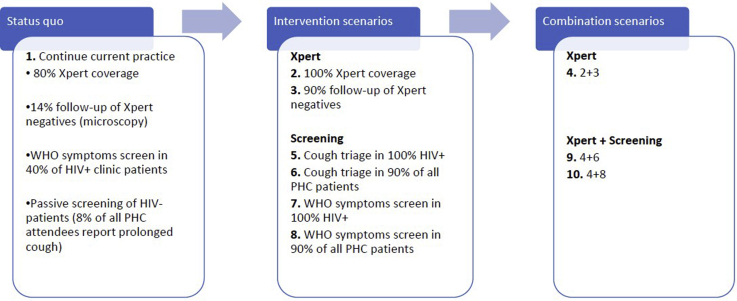
Modeled interventions.